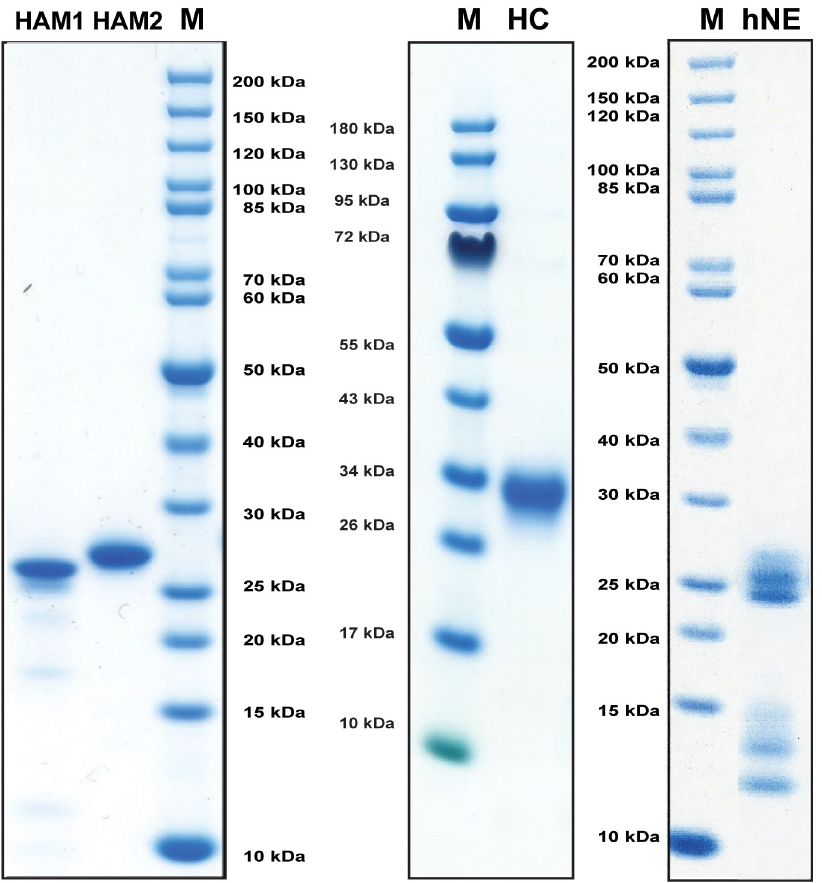
Fig 2. SDS-PAGE of purified chymases and related reference proteases used in this study. Three different recombinant mast cell chymases were expressed in a baculovirus expression system. The purified active enzymes were analyzed by separation on SDS-PAGE and visualized with Coomassie Brilliant Blue staining. Proteases: HC, human chymase; hNE, human neutrophil elastase; HAM 1 and 2, hamster chymases 1 and 2. M is molecular weight